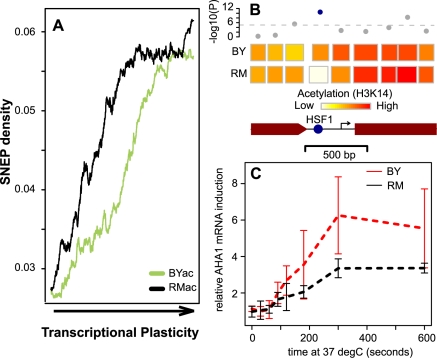
SNEP correlation with transcriptional plasticity.(A) SNEP density is correlated to transcriptional plasticity genome-wide. 4,232 genes were ranked according to their plasticity values from Tirosh et al. [36] on the x-axis. BYac and RMac SNEP frequencies were counted among nucleosomes located in each gene (coding region plus and minus 250 bp), and averaged in 500-genes sliding windows (y-axis). (B) Scheme of nucleosome organization in the regulatory region of the AHA1 gene. Rectangles represent nucleosomes, colored according to the mean log(ac/nuc) value across all probes of the nucleosome. SNEP detection (-log10(P-value)) is indicated above each nucleosome, with significance cutoff indicated as a dashed line. A highly significant SNEP covers the DNA binding site for HSF1 transcription factor (blue spot). Arrow, transcription start site. Brown box, beginning of coding sequence. (C) Differences in kinetics of AHA1 mRNA expression during heat-shock. Four independent experiments were performed. In each case, cultures of exponentially growing BY (red) and RM (black) cells were shifted from 30°C to 37°C, and cells were collected at indicated times after the transition. AHA1 mRNA was quantified by quantitative real-time PCR with reverse-transcription relative to ACT1 mRNA (a gene known to be stable after heat shock). Bars: +/− standard deviations.